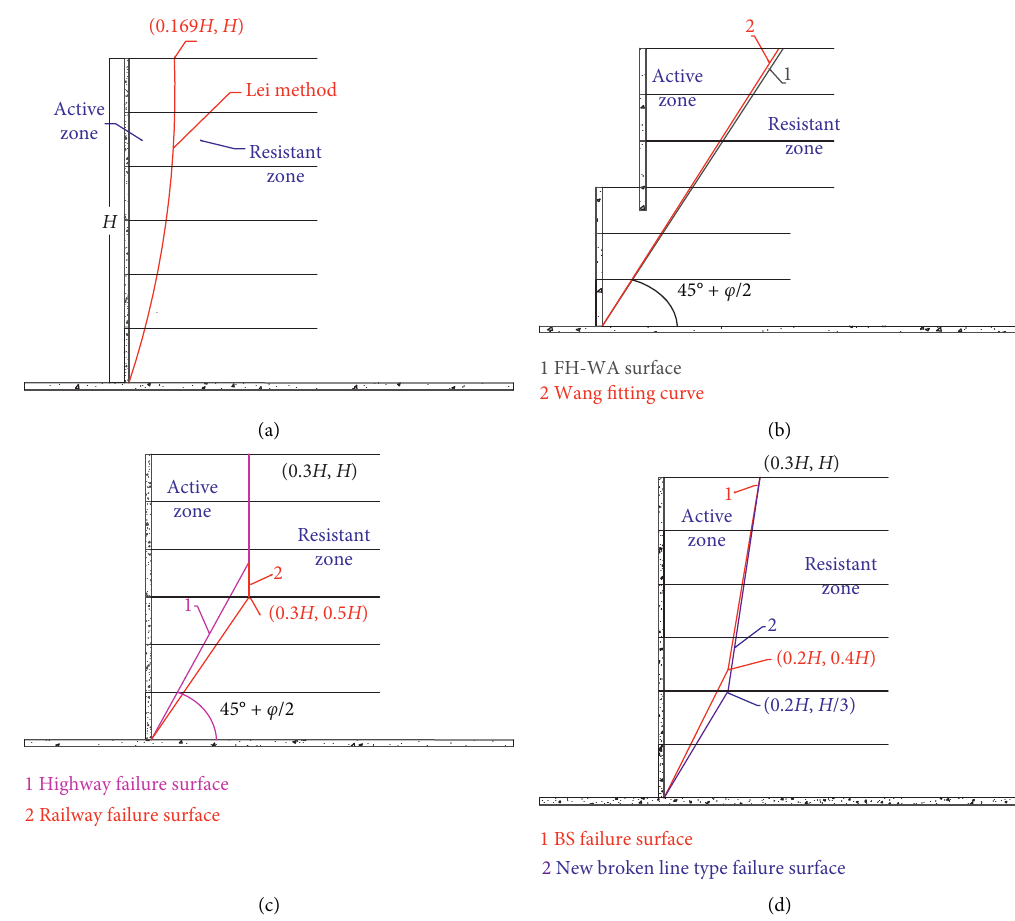
Figure 1: Existing hypothesis of the potential failure surface. (a) Log spiral failure surface. (b) Linear failure surface. (c) Simplified failure surface of 0.3 H . (d) Broken line failure